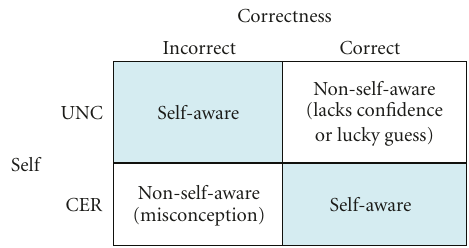
Figure 3: Transparency: we consider speakers to be transparent if their internal level of certainty reflects their perceived level of